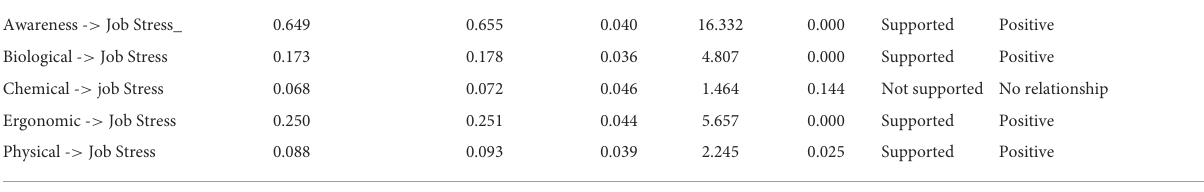
TABLE 3 Path coefficient.